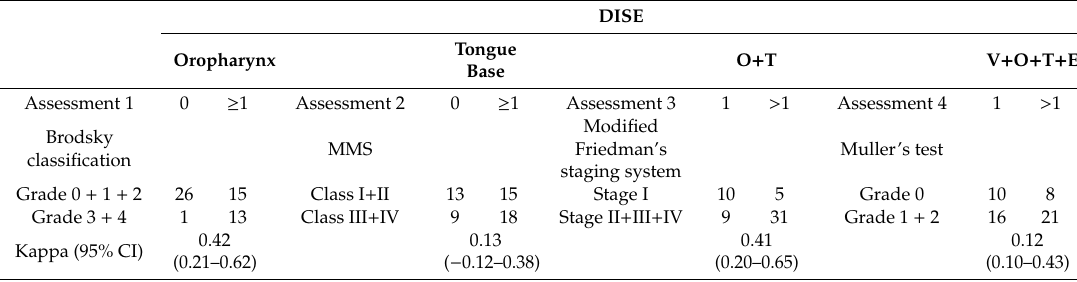
Table 3. Correlation coe ffi cients between di ff erent levels of Brodsky classification, MMS, Friedman stage and di ff erent level DISE. Oropharynx